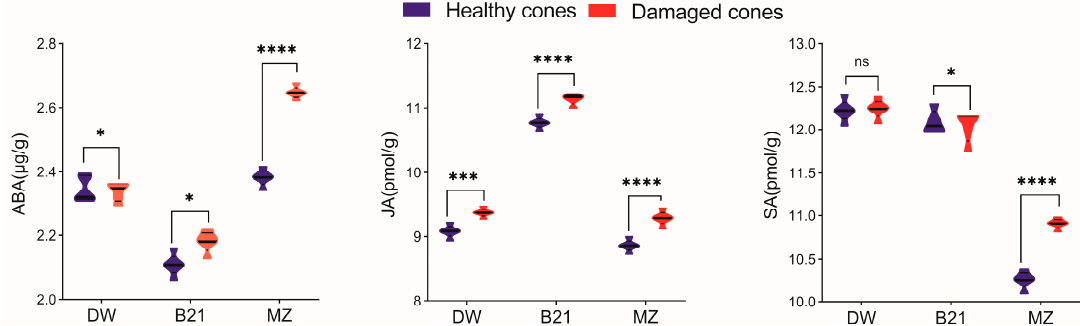
Figure 3. The hormone content (Mean ± SE) in the shells of different hazel cultivars before and after chewing by C. nucum . ns p ≥ 0.05, * p < 0.05, *** p < 0.001 and **** p < 0.0001.